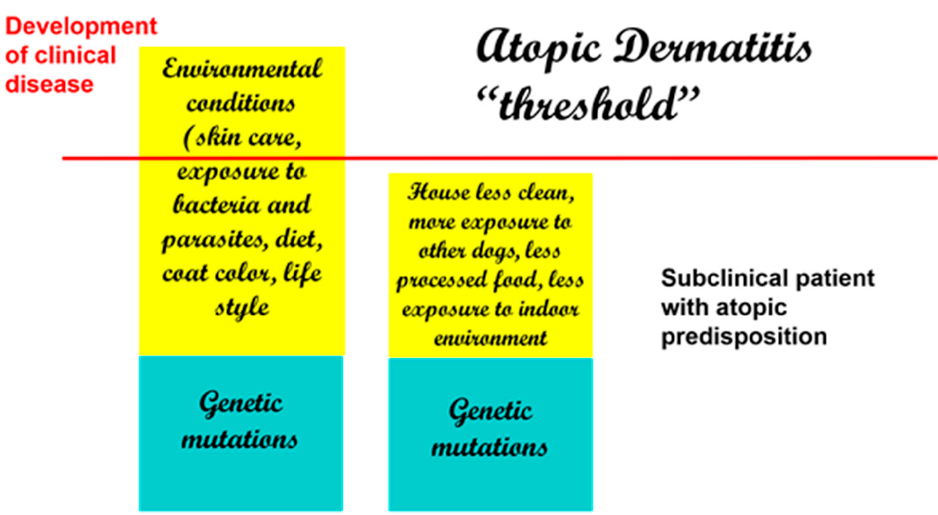
Figure 2. Development of clinical disease is the result of genetic and environmental factors. Decreased exposure to beneficial bacteria and increased exposure to indoor allergens and processed foods are some of the reported risk factors in dogs.